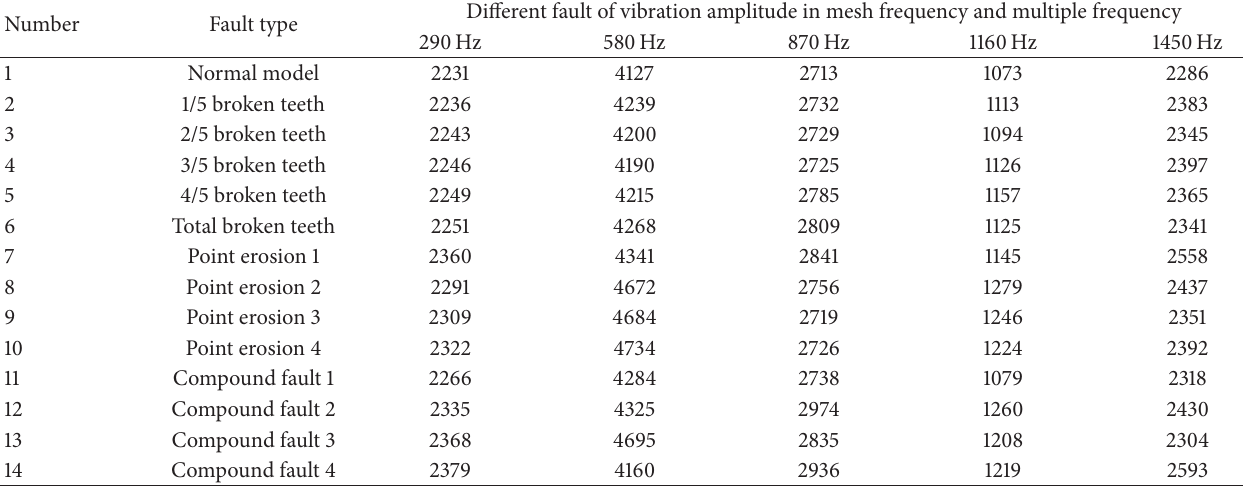
Table 5: The fault experimental data.